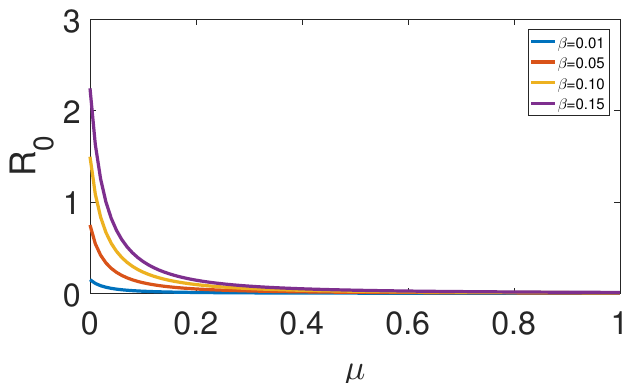
Figure 5. The plot of the basic reproduction number as a function of the birth–death rate µ for several values of the contact